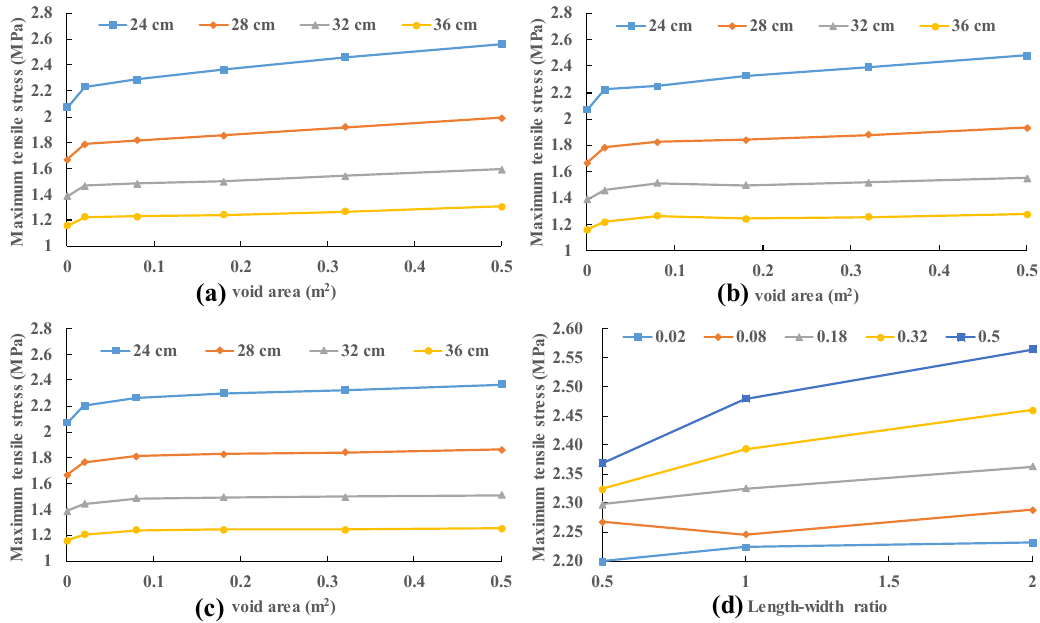
Figure 9. Variation in stress of the slab with various sizes and length–width ratio of void area: ( a ) length–width ratio = 2; ( b ) length–width ratio = 1; ( c ) length–width ratio = 0.5; and ( d ) slab thicknesses = 24 cm.